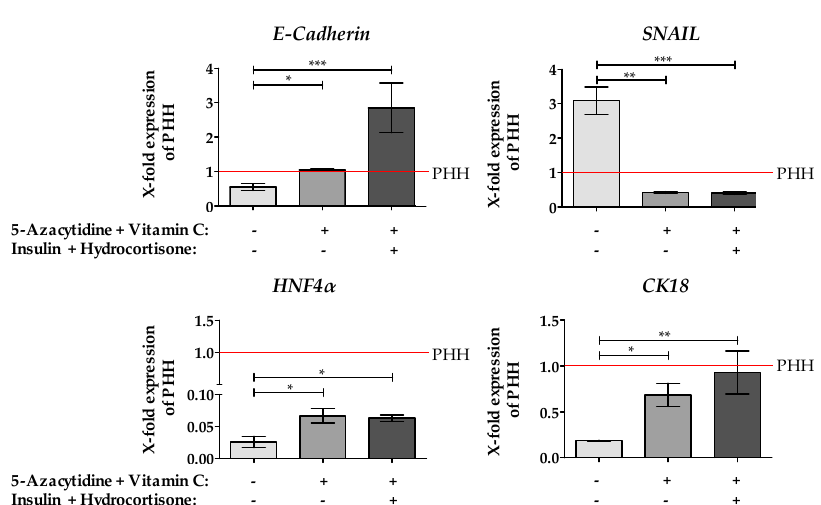
Figure 4. Effect of epigenetic modifying compounds on the expression of epithelial and EMT marker genes. Treatment of the cells with 10 µM 5-Azacytidine (5-AZA) plus 0.5 mM Vitamin C dark bars) and in the presence of insulin plus hydrocortisone (black bars) resulted in significant changes of epithelial and EMT marker genes. The expression level of the EMT marker Snail1 ( SNAIL ), the epithelial marker genes E- Cadherin and Cytokeratin 18 ( CK18) and the hepatic key regulator gene Hepatocyte nuclear factor 4 α (HNF4 α ) were measured by qRT-PCR. Unstimulated HepG2 cells (grey bars) as well as PHH (red line) served as control and reference culture. Values were normalized to GAPDH and represent the mean of N = 3, n = 3. As positive reference served a pool of five different primary human hepatocyte (PHH) donors. Bars represent Mean ± SEM, * p ≤ 0.05, ** p ≤ 0.01, *** p ≤ 0.001 as indicated.